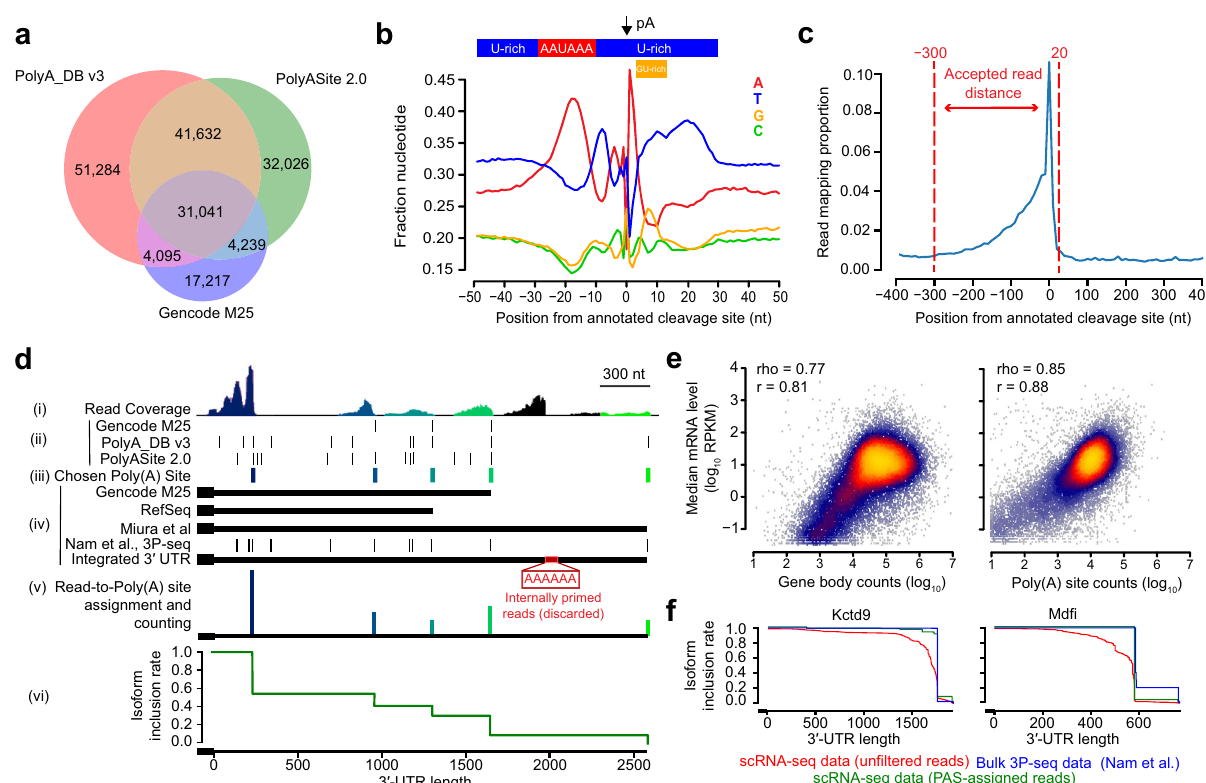
Fig. 1 A computational pipeline to accurately quantify 3 ′ -UTR isoform abundances from scRNA-seq data. a Venn diagram of a set of three PAS annotation resources and their degree of intersection. A PAS intersecting within ± 20 nt from another was considered an intersecting hit to account for the heterogeneity of the cleavage and polyadenylation machinery 16 . b Pro fi le of nucleotide frequencies in the ± 50 nt vicinity of the annotated cleavage site position, derived from the union of the three databases. Shown above the plot are the known positionally enriched mammalian motifs known to guide mRNA cleavage 34 . c Distribution of scRNA-seq reads mapping within the ± 400-nt vicinity of the annotated cleavage site position, derived from the union of the three databases. To avoid an ambiguous signal, the analysis was restricted to PASs not within the same ± 400-nt window as another PAS. Data are binned at 5-nt resolution. Shown within the dotted red lines are the acceptable distance thresholds to associate a read to an annotated PAS. See also Supplementary Fig. 1 for comparisons of ( b , c ) for each individual PAS database. d Schematic depicting the association of each scRNA-seq read to a PAS in order to quantify relative PAS abundances for a gene. Shown from top to bottom are: (i) the read coverage of scRNA-seq reads mapped to the gene. (ii) The three PAS annotation resources considered, showing the location of each PAS along the 3 ′ -UTR. (iii) The subset of chosen PASs to which reads were greedily assigned, colored from blue to green to indicate which reads from the coverage plot were assigned to them. (iv) The three gene annotation databases integrated with bulk 3P-seq data from ten tissues and cell lines 8 to identify the longest known 3 ′ -UTR. This integrated 3 ′ -UTR was used to associate PASs to the gene. (v) A visualization of relative 3 ′ -UTR isoform abundances after read-to-PAS assignment, with vertical lines at each chosen PAS proportional to the assigned number of read counts. Reads not overlapping within the − 300 to + 20 vicinity of a known PAS were treated as likely internal priming artifacts and discarded. (vi) The resulting isoform inclusion rate (IIR) plot to quantify the cumulative proportion of 3 ′ -UTR isoforms remaining along the length of a 3 ′ -UTR. See also Supplementary Data 1 for the integrated 3 ′ -UTR database and gene annotations. e Scatter plots comparing gene expression levels estimated using scRNA-seq read abundances mapping to the full gene body (left panel) or the sum of reads mapping to PASs (right panel), relative to median gene expression levels from bulk RNA-seq data 37 ( n = 19,517 protein-coding genes). Regions are colored according to the density of data from light blue (low density) to yellow (high density). Shown are the corresponding Pearson ( r ) and Spearman (rho) correlations for each comparison. See also Supplementary Fig. 2 for sequence features explaining biased estimates in the gene body approach. f Shown are IIR plots for two genes, comparing the pro fi les for the raw scRNA-seq data and post-processed data after read-to-PAS assignment with respect to the pro fi le for bulk 3P- seq data 8 as a gold standard. Slight vertical jitter was added for enhanced line visibility. See also Supplementary Fig. 3 for a global comparison among all